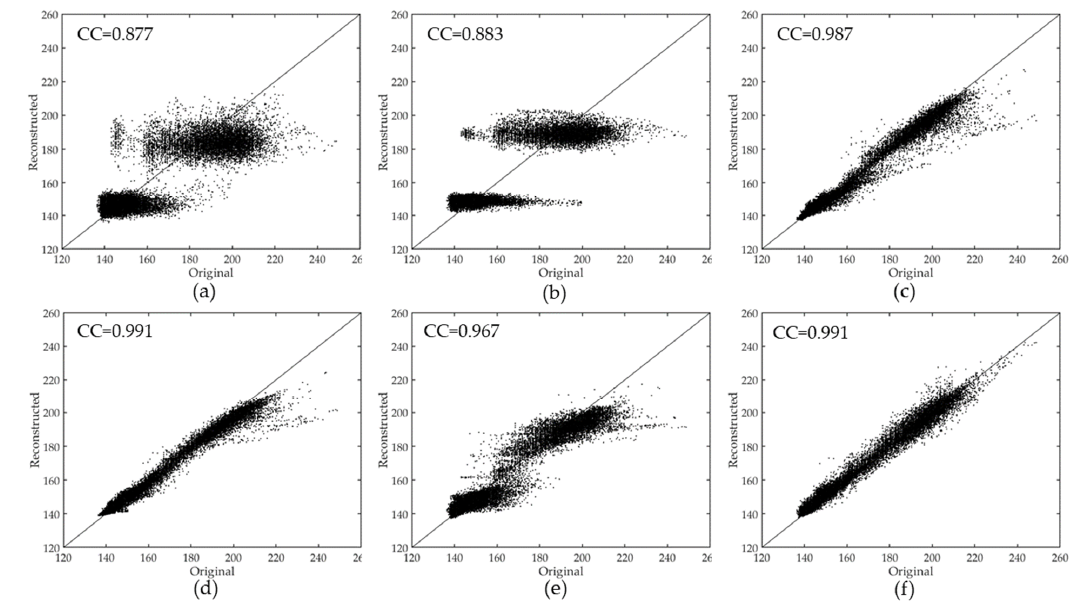
Figure 12. The scatterplots of the original and the reconstructed values in the second simulated experiment: ( a ) the FaLRTC method; ( b ) the HaLRTC method; ( c ) the TRPCA method; ( d ) the TVLRSDC method; ( e ) the TOS method; ( f ) the proposed TSSTO method.